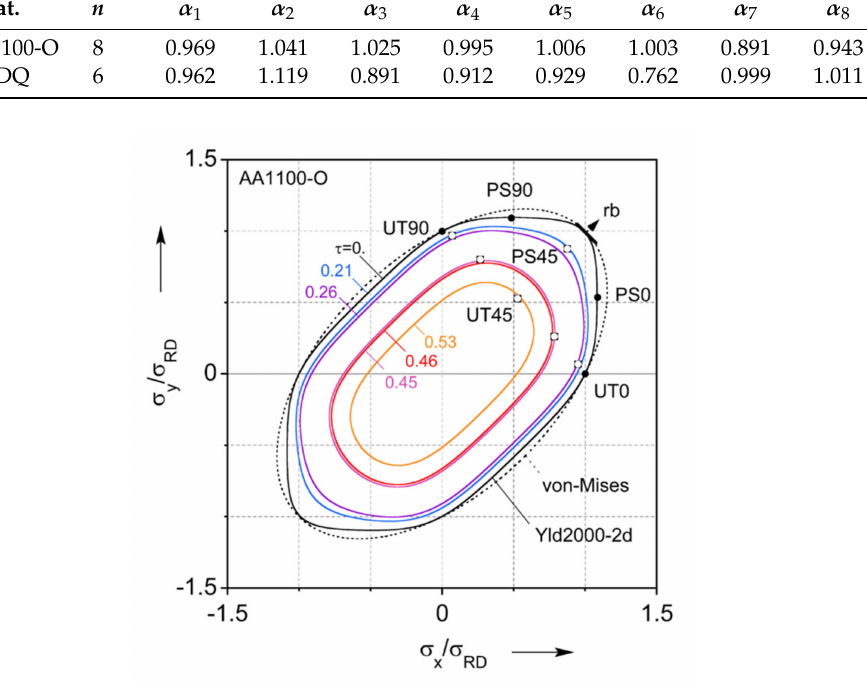
Table 2. Parameter calibration of non-quadratic anisotropic yield function (Yld2000-2d). Mat.